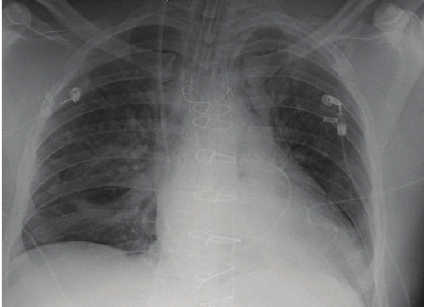
Figure 2: Chest X-ray: clear lungs, cardiomegaly, and wide medi- astinum.